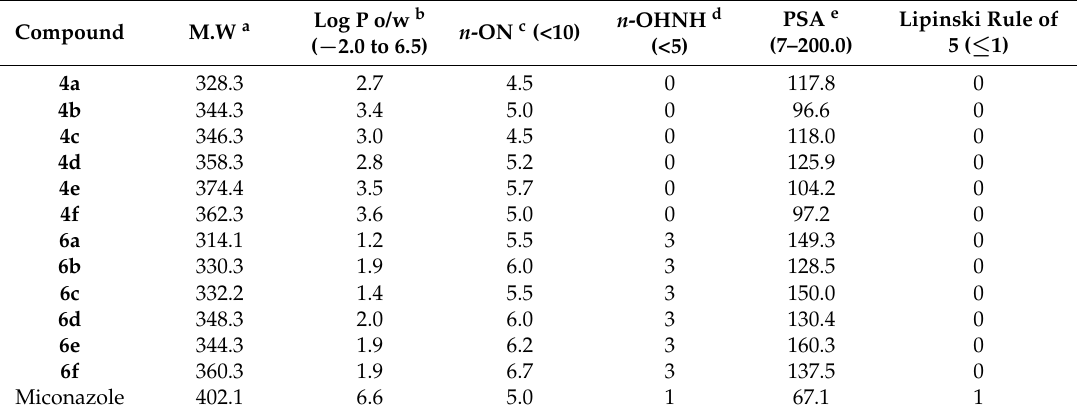
Table 9. In silico physicochemical pharmacokinetic parameters important for good bioavailability according to Lipinski rule of 5 for the synthesized compounds 4(a–f) and 6(a–f).